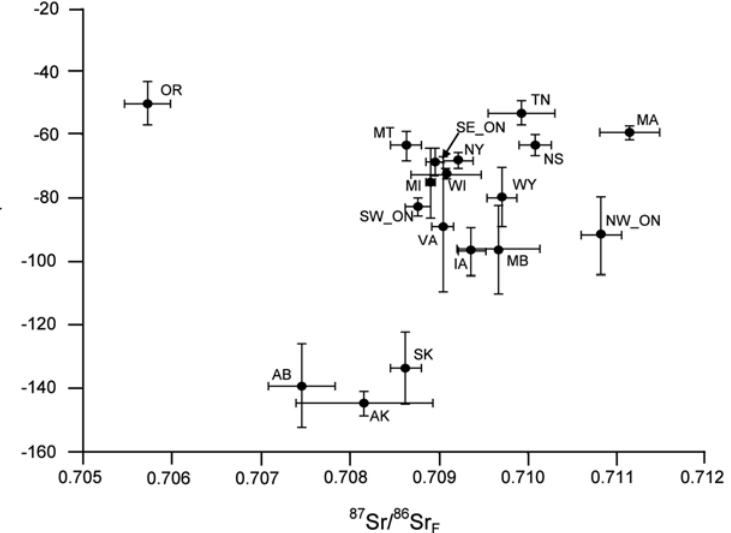
Figure 2. Relationship between d D and 87 Sr/ 86 Sr values in Tree swallows sampled across North America. Values are mean 6 s.e. from primary flight feathers. Abbreviations are: AB=Red Deer, Alberta; AK=McCarthy, Alaska; IA=Ames, Iowa; MA=Amherst, Massachusetts; MB=Brandon, Manitoba; MI=Allendale, Michigan; MT=Monarch, Montana; NS=Wolfville, Nova Scotia; NW ON=Thunder Bay, Ontario; NY=Ithaca, New York; OR=Portland, Oregon; SE ON=Elgin, Ontario; SK=Saskatoon, Saskatchewan; SW ON=Guelph, Ontario; TN=Lenoir City, Tennessee; VA=Waynesboro, Virginia; WI=Saukville, Wisconsin; WY=Big Horn, Wyoming.